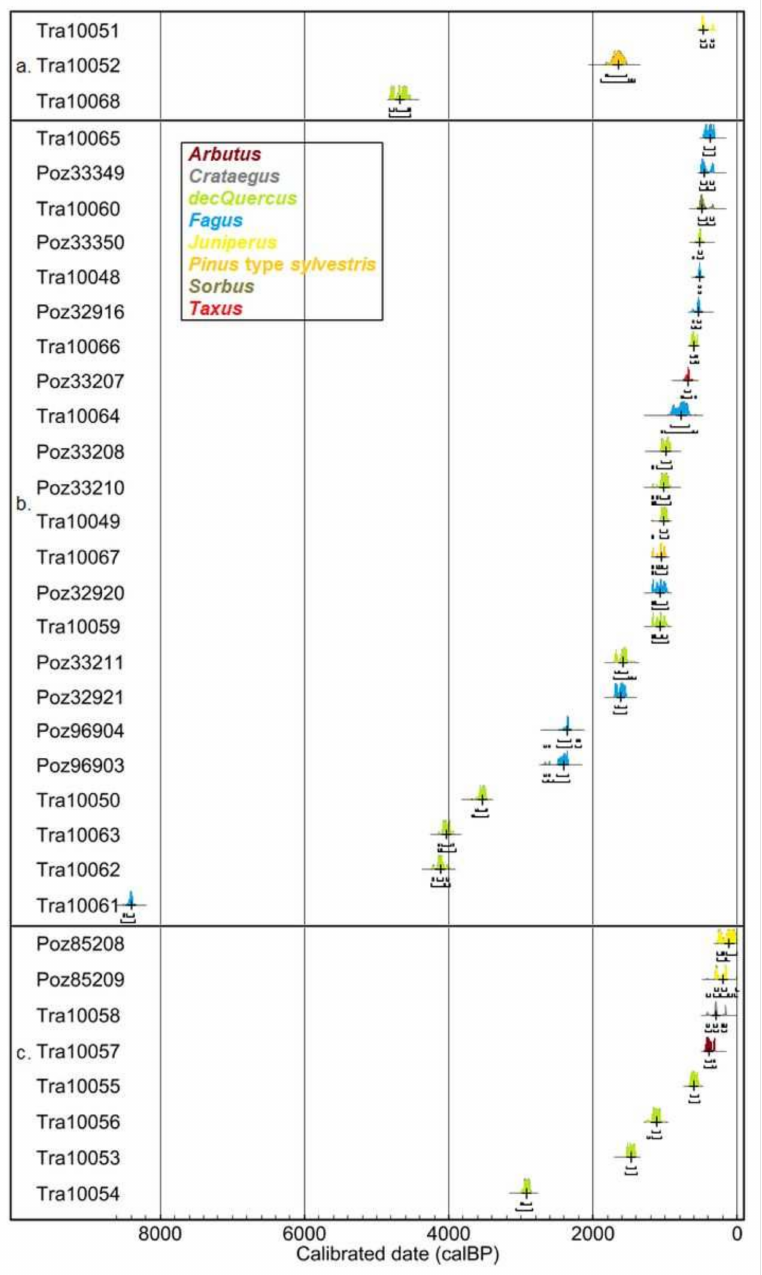
Figure 6. Age distribution of the dated charcoal pieces from the study area for each ecological unit sampled ( a ) northern plateau; ( b ) Sainte-Baume forest; and ( c ) southern exposure) according to dates obtained from 14C accelerated mass spectrometry (AMS) calibrated with a two-standard-deviation (2 σ ) 95% confidence interval on the OxCal program [60] with the IntCal20 dataset